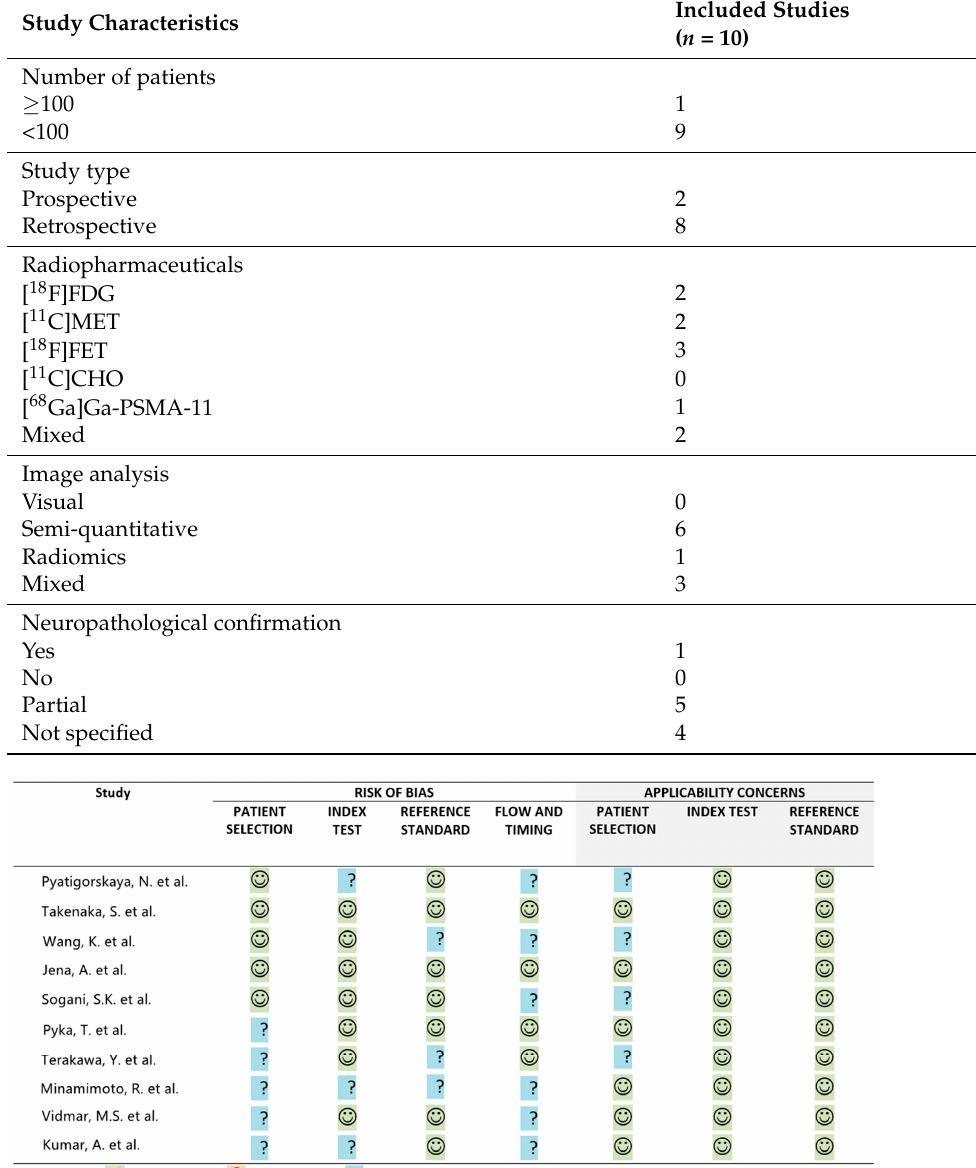
Figure 2. QUADAS.2 Figure 2. QUADAS.2 results.